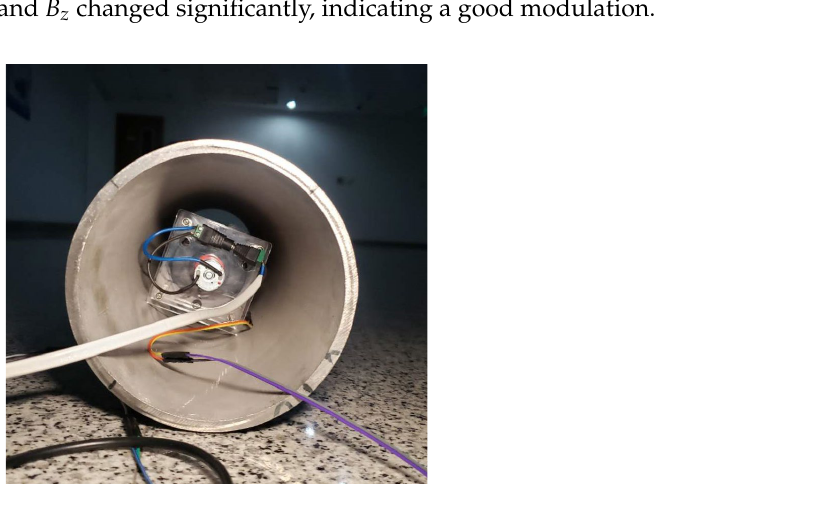
Figure 10. The mechanical antenna placed in an actual 20# steel pipeline. Table 2. Measured results.